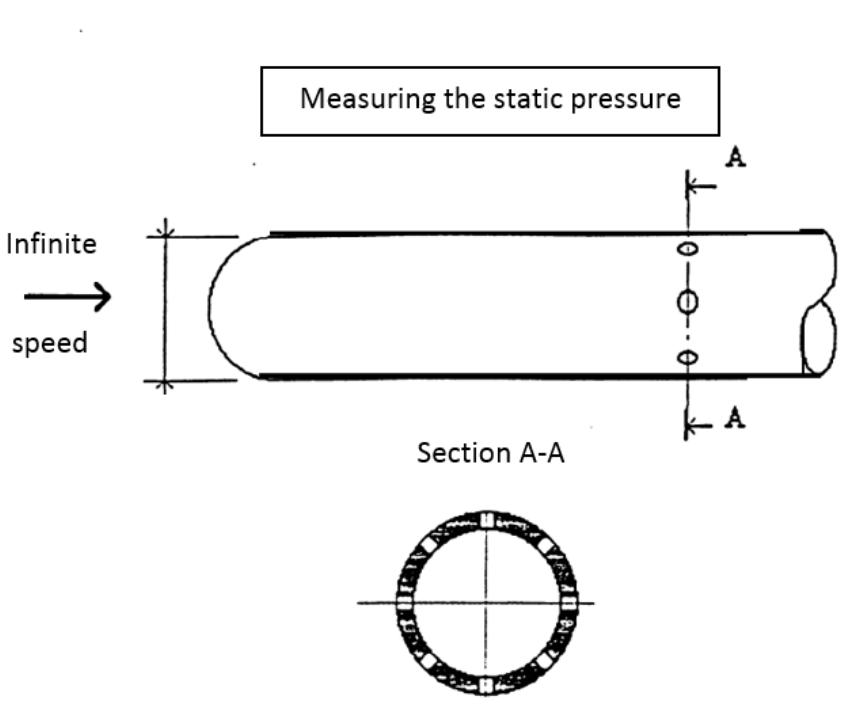
Figure 2. Static pressure measurement